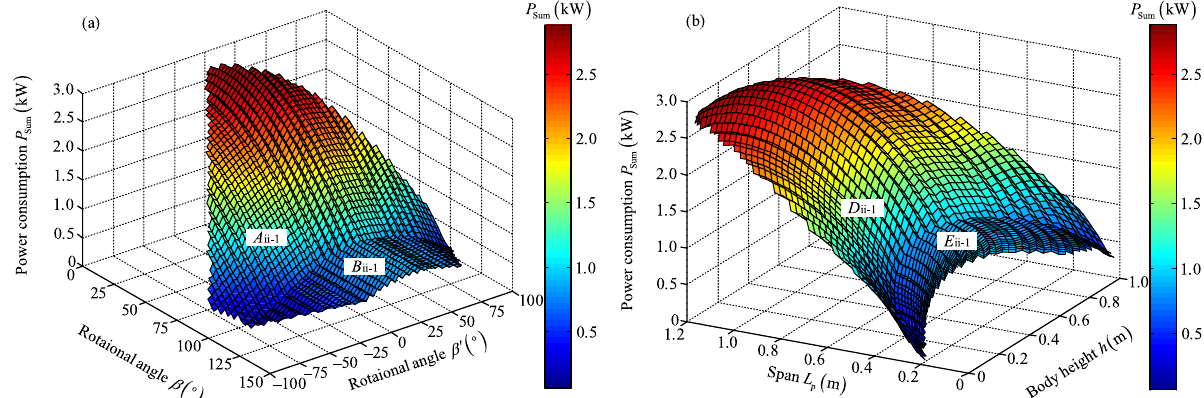
Figure 11 Variable tendency charts of P sum under secondary working conditions ii-1: a With changes in β ′ and β , b with changes in h and L p